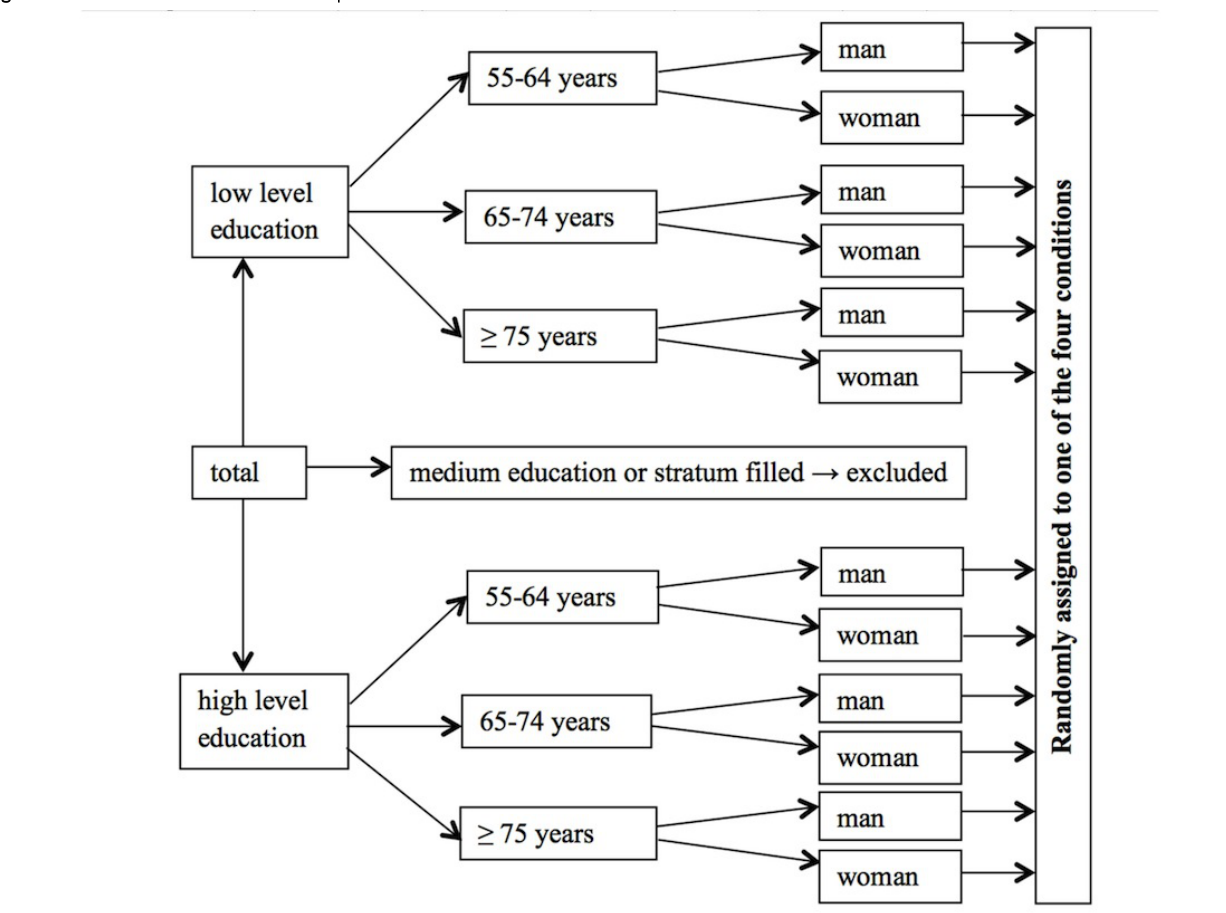
Figure 1. Flow chart of the stratification